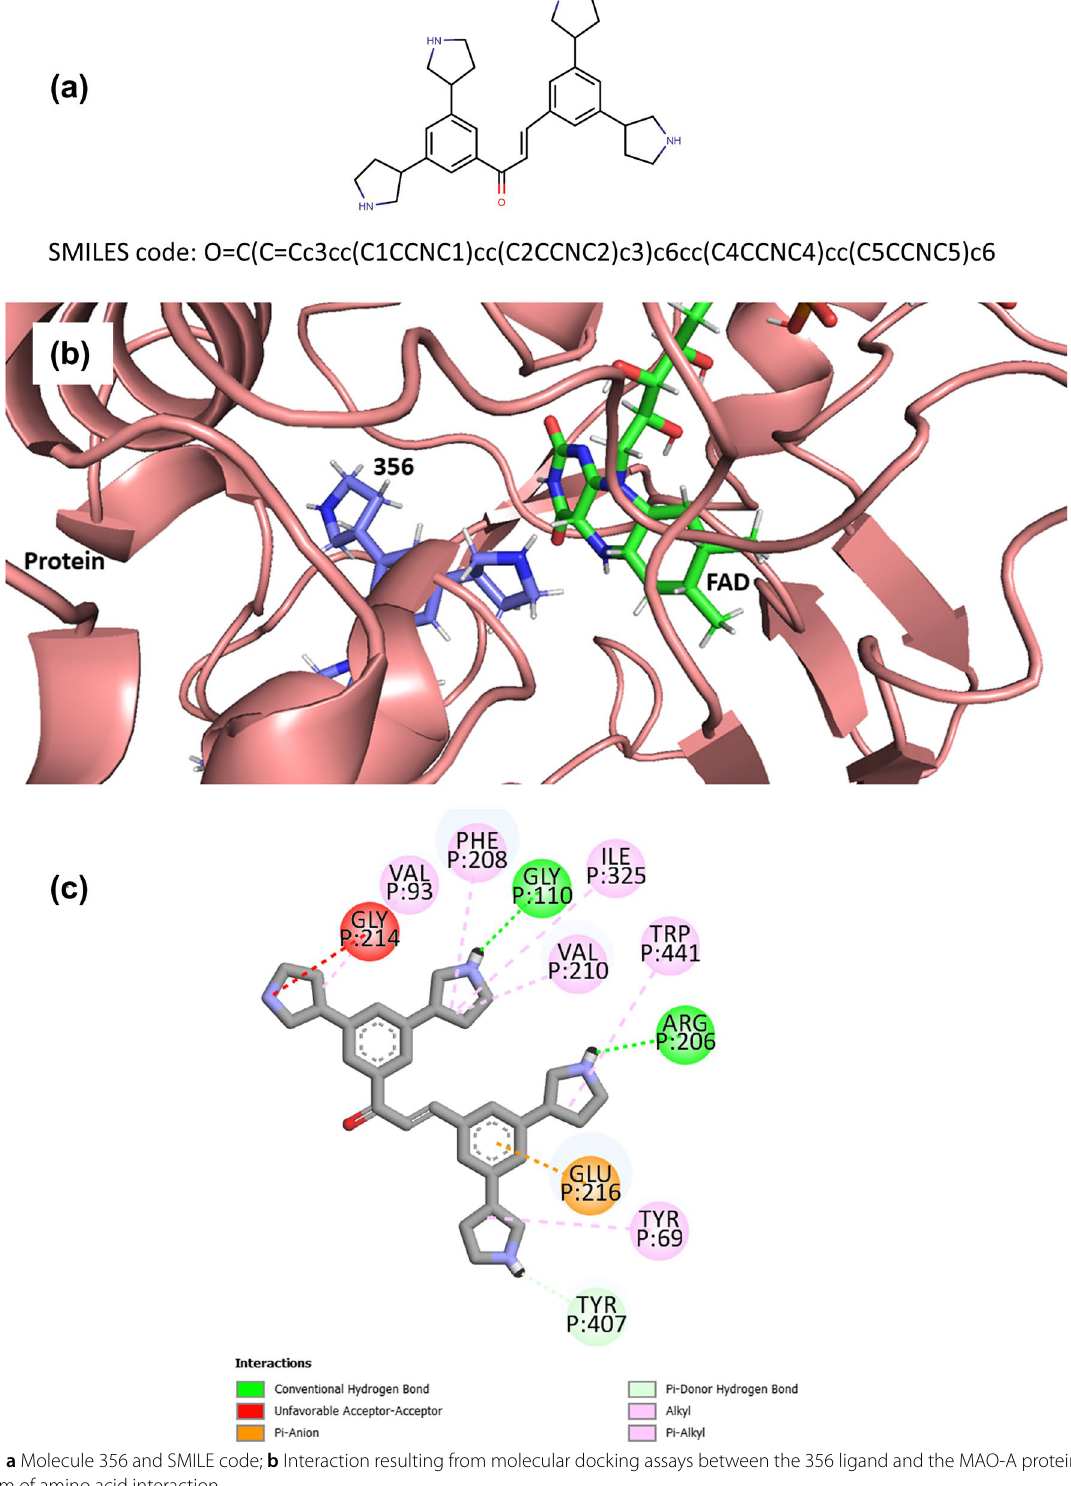
Fig. 2 a Molecule 356 and SMILE code; b Interaction resulting from molecular docking assays between the 356 ligand and the MAO‑A protein; c 2D diagram of amino acid